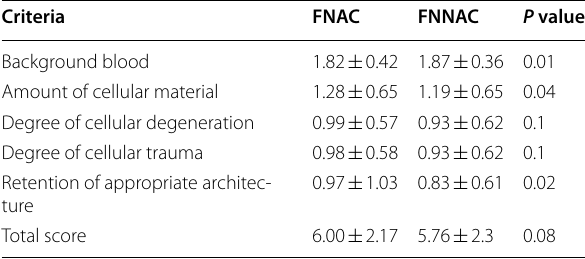
Table 9 Comparison between different studies regarding degree of cellular trauma using FNAC vs FNNAC [10] Degree of cellular trauma